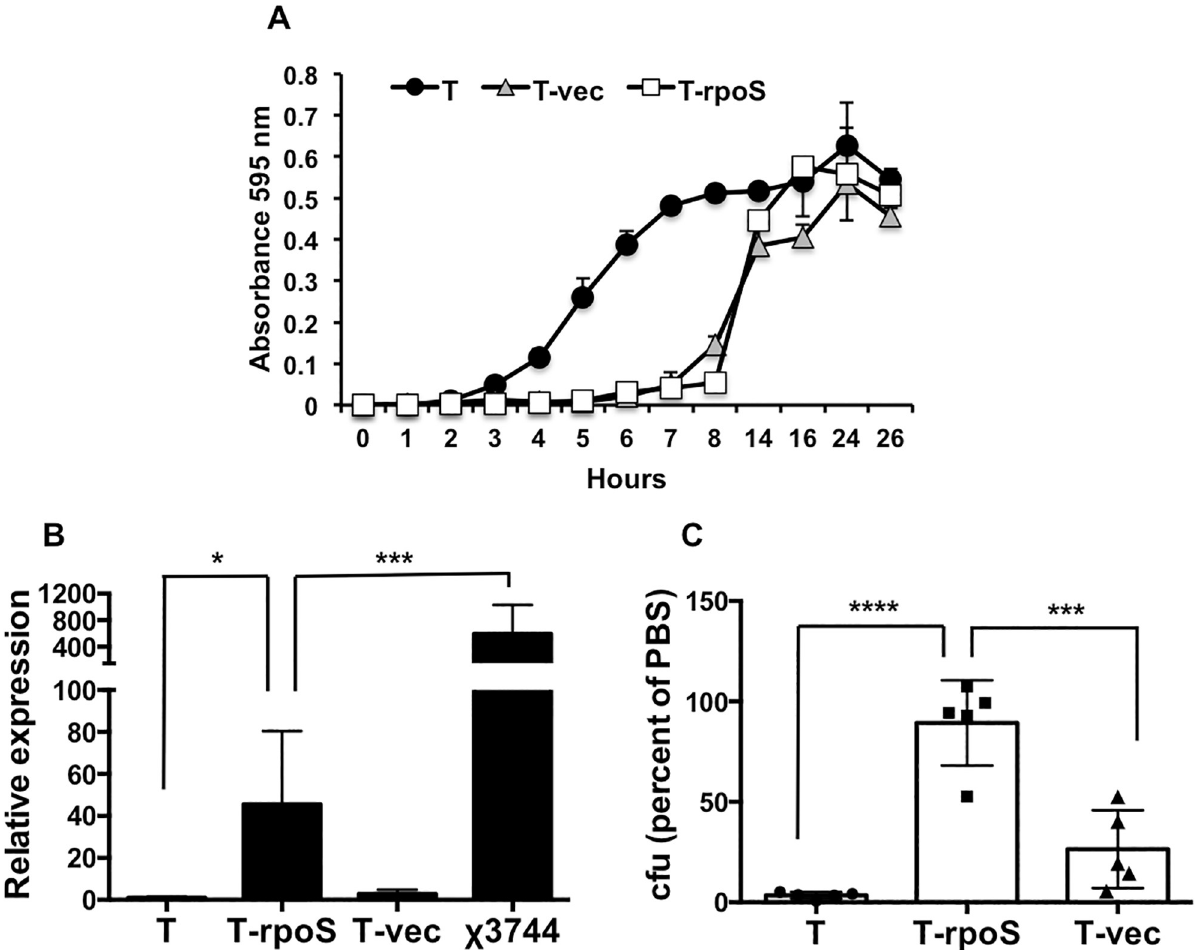
Fig 5. Expression of wild-type rpoS in in Ty2. A. Overnight shaking cultures of Ty2 (T), Ty2 transformed with wild-type rpoS (T-rpoS) and Ty2 transformed with empty vector (T-vec) were diluted 1000-fold into fresh LB and the bacteria were grown at 37˚C with shaking at 220 rpm. Growth curves were generated as described in the methods section. B. Expression of the katE gene in overnight shaking cultures of Ty2 (T), Ty2 transformed with wild-type rpoS (T-rpoS), Ty2 transformed with empty vector (T-vec) and χ 3744 (wild-type rpoS ) was determined by quantitative reverse transcription-PCR. Levels of the transcript in each strain were calculated relative to the level in Ty2. � p = 0.034, ��� p = 0.0002, n = 6 per group. C. Equivalent numbers of Ty2 (T), Ty2 transformed with wild-type rpoS (T-rpoS) and Ty2 transformed with empty vector (T-vec), grown overnight in shaking cultures, were incubated in PBS or PBS containing 0.1 mM hydrogen peroxide for 1 hour at 37˚C. The number of bacteria surviving in hydrogen peroxide was determined and expressed as a percentage of the number in PBS for each strain (the values for PBS are not shown for ease of visualization). ��� p = 0.0001, ���� p < 0.0001, n = 5 per group. The difference between T and T-vec was not statistically significant.